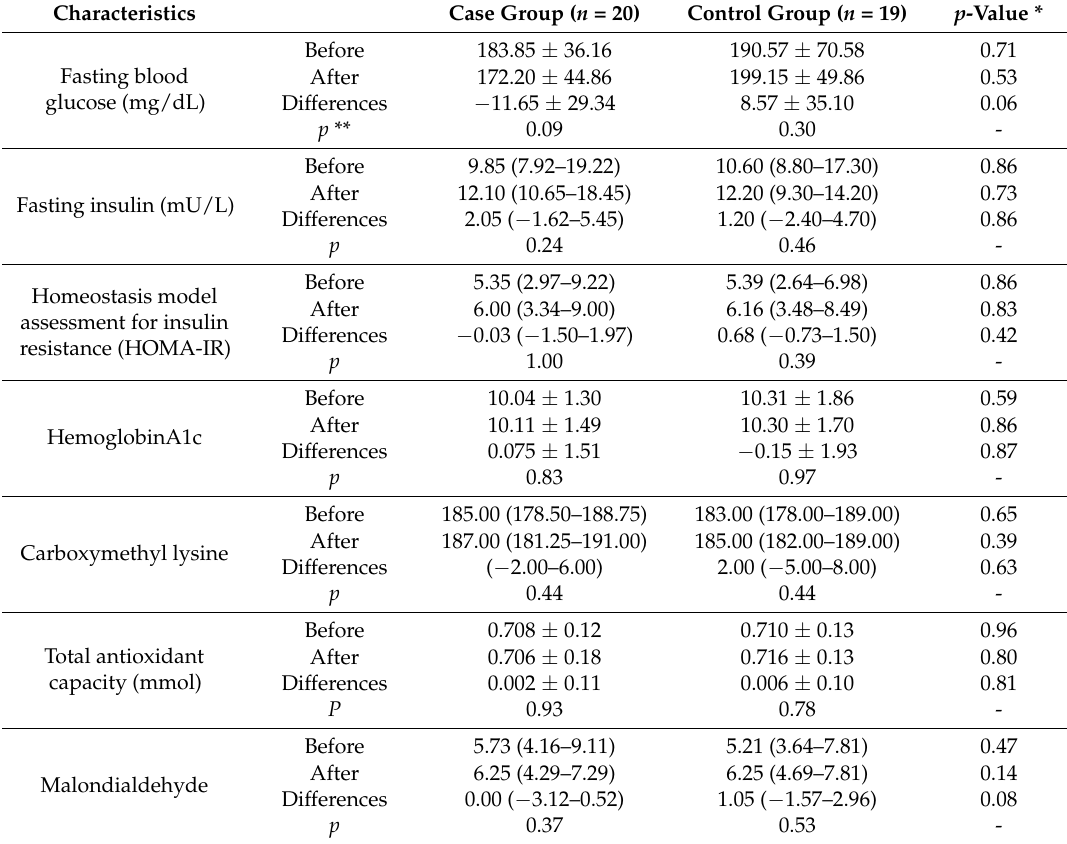
Table 2. Comparison of variables in the groups of patients before and after the